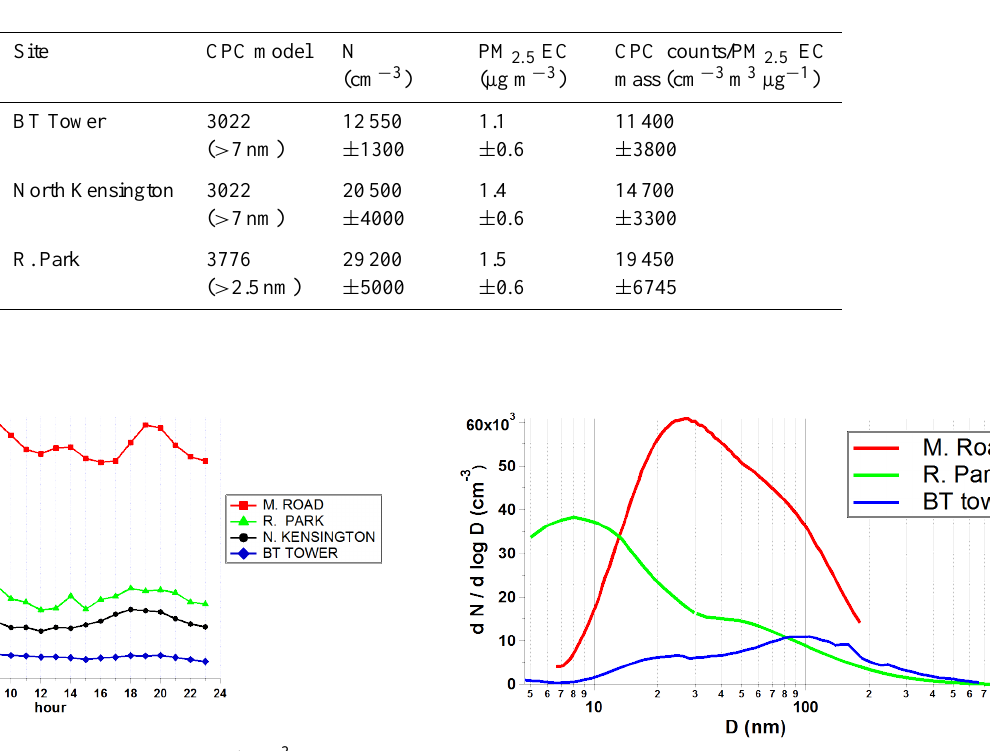
Table 2. Relationship of particle number count from CPC to elemental carbon concentrations for three sites.